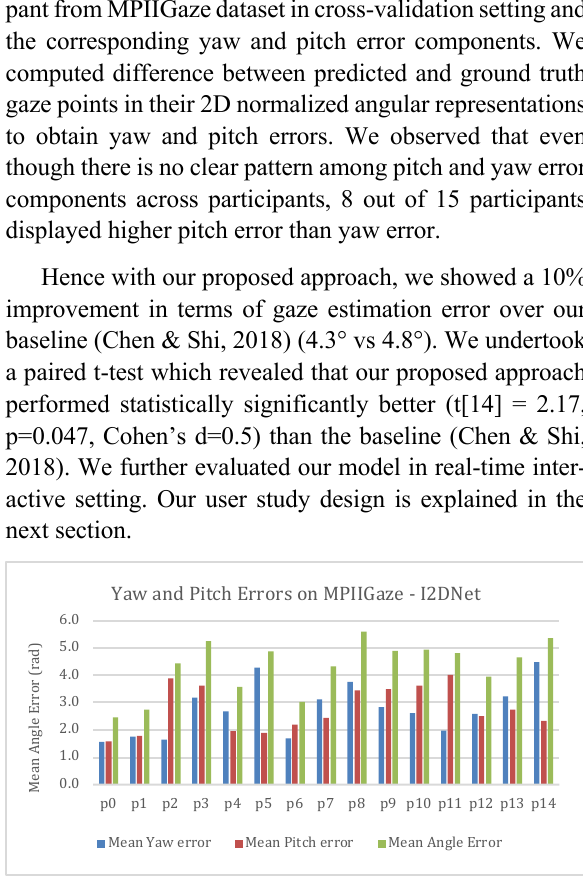
Figure 2. Mean Angle Errors for all participants in MPIIGaze using